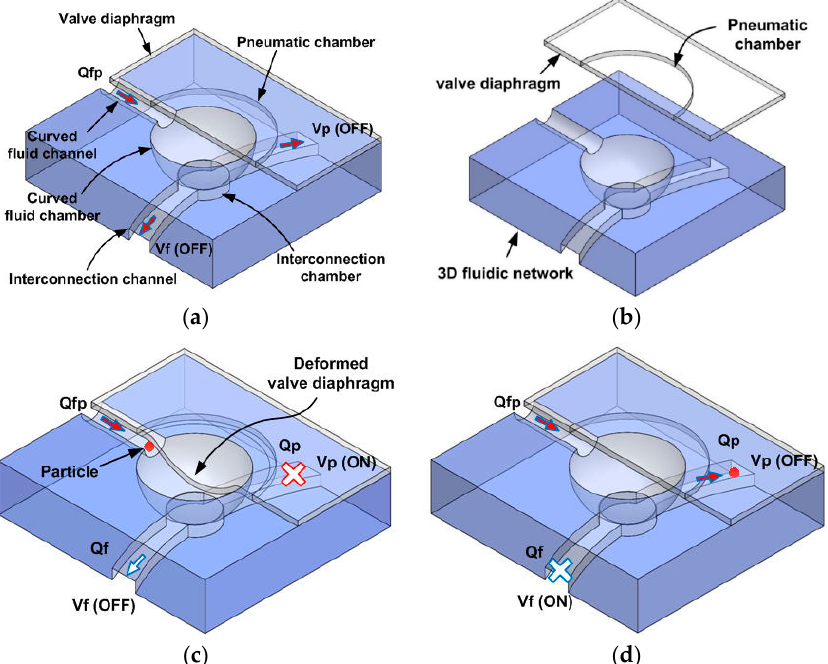
Figure 2. Operation of the particle concentration. ( a ) A schematic of the sieve valve (Vs), ( b ) assembly, ( c ) particle sieving, ( d ) release of concentrated particles.